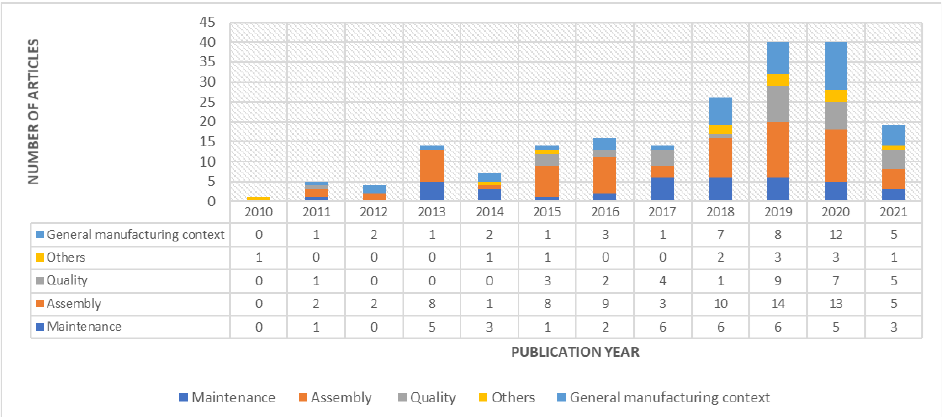
Figure 8. Distribution of AR solutions in different fields over